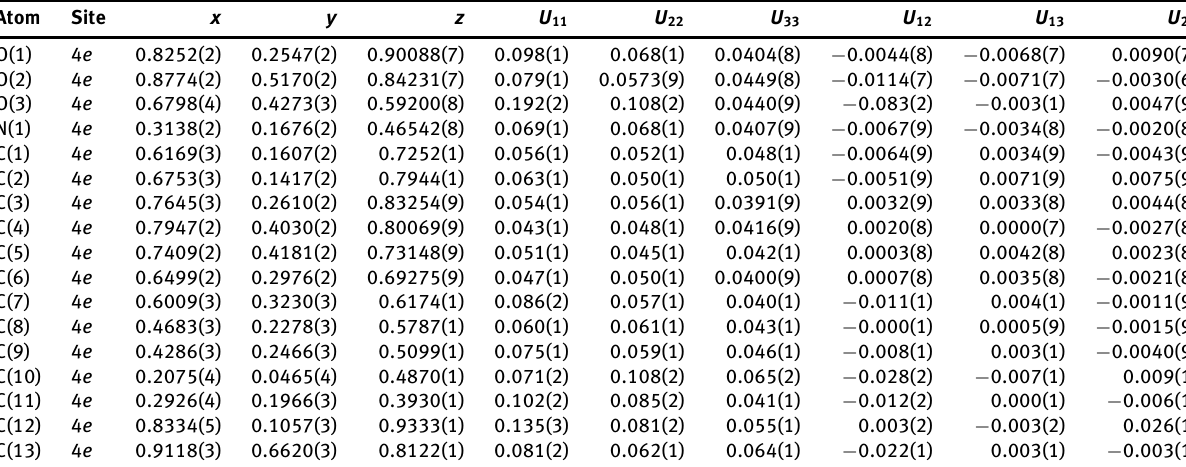
Table 3: Atomic coordinates and displacement parameters (Å 2